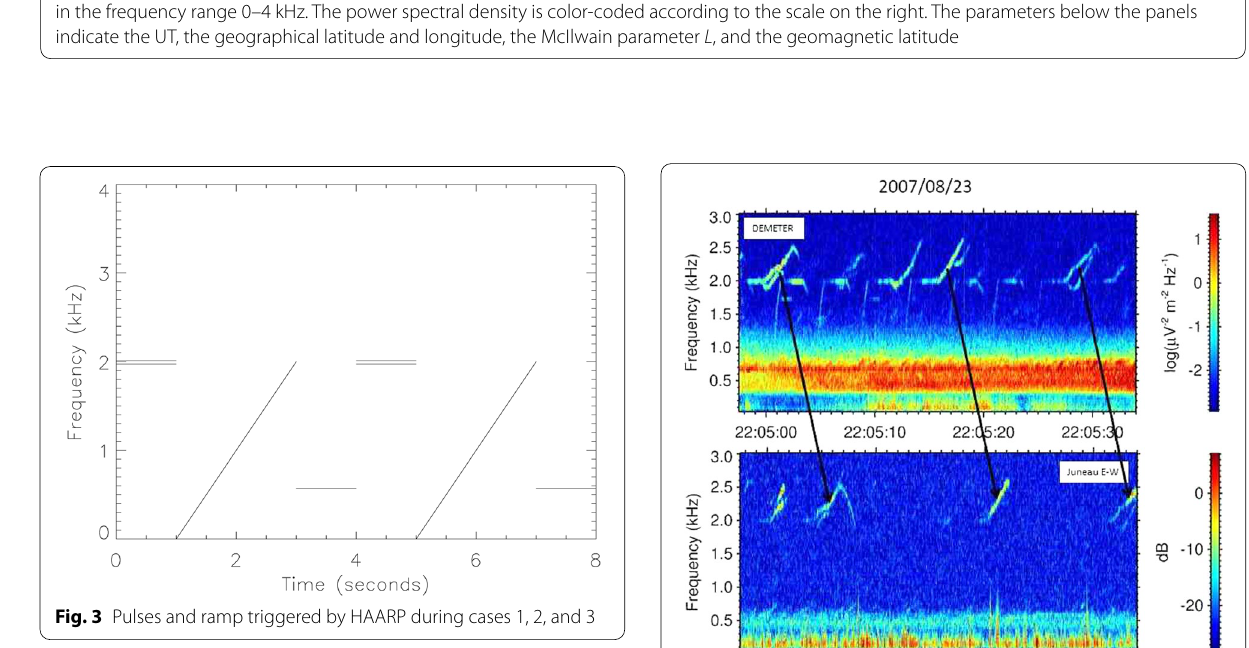
emissions observed by DEMETER propagate in ducts that do not extend below 1000 km altitude, so that they are reflected from the bottom of the ionosphere and do not reach the ground.